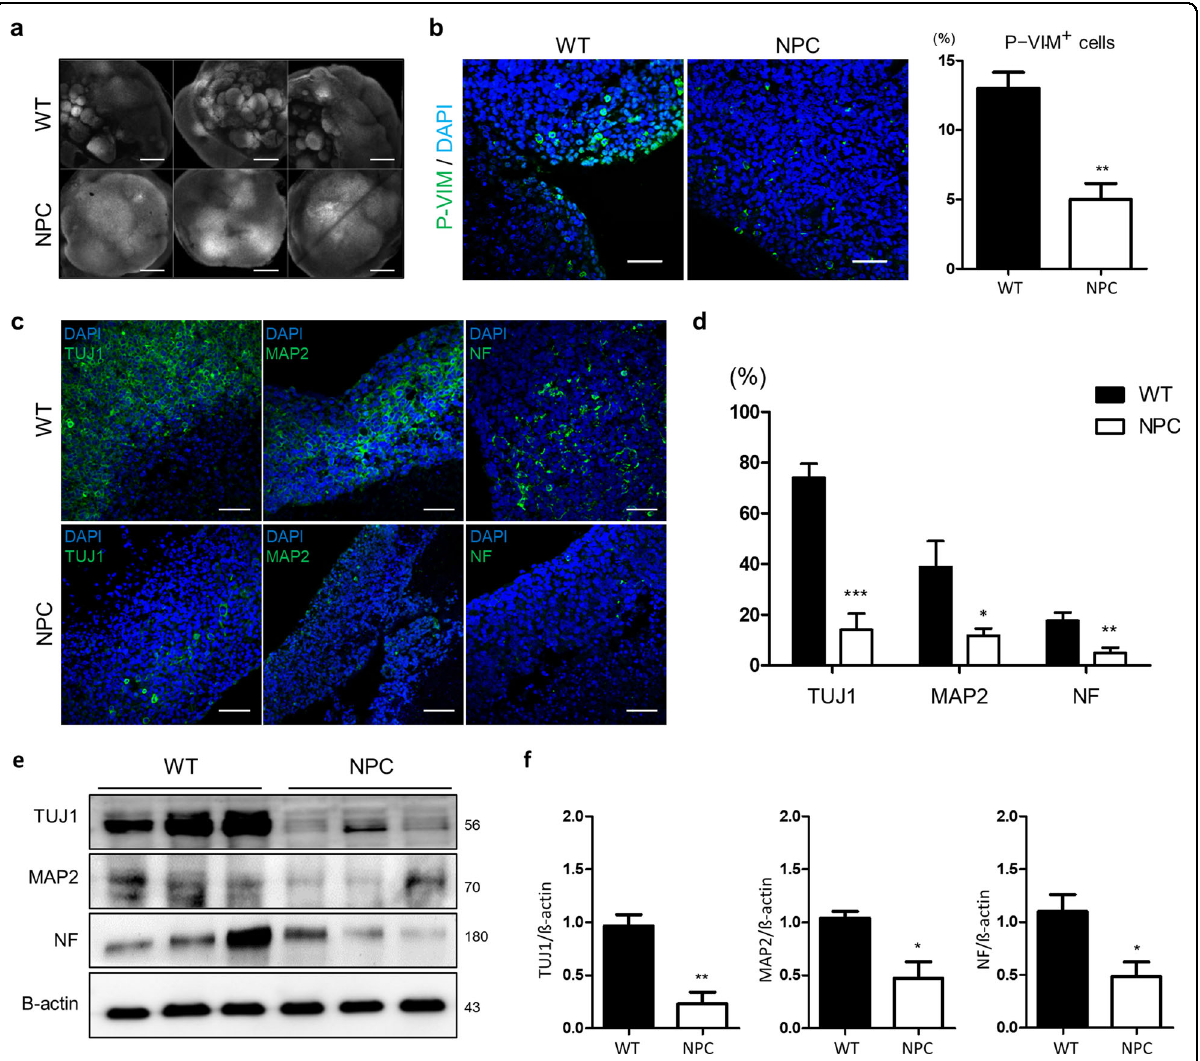
Fig. 2 Decreased neuronal markers in NPC organoids. a Clearing and immunostaining with DAPI in the WT and NPC organoids at day 28. Scale bars, 500 μ m. b Immunostaining for mitotic radial glia (phospho-vimentin) in the outer region. Scale bars, 50 μ m. c Staining for neuronal markers (TUJ1, NF, and MAP2) in the WT and NPC organoids at day 28. Scale bars, 50 μ m. d The percentage of the total number of cells that expressed TUJ1, NF, and MAP2 of the total number of DAPI-positive cells counted in each group was determined. e , f Western blot analysis and quanti fi cation of neuronal markers (TUJ1, NF, and MAP2) reveals a reduction in the NPC organoids on day 28. Every experiment was performed in triplicate. The results are the mean ± SD. * p < 0.05, ** p < 0.01, and *** p <